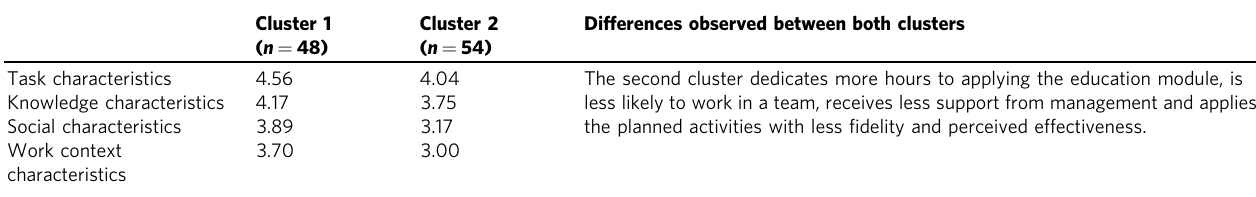
Table 6 Final centres of the two clusters according to the characteristics of the work ( n =